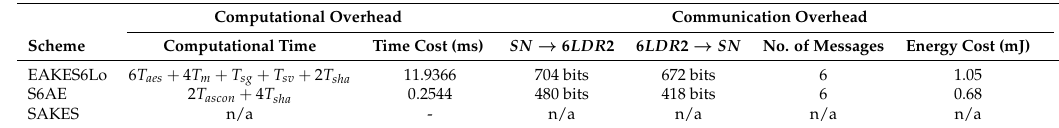
Table 10. Handover